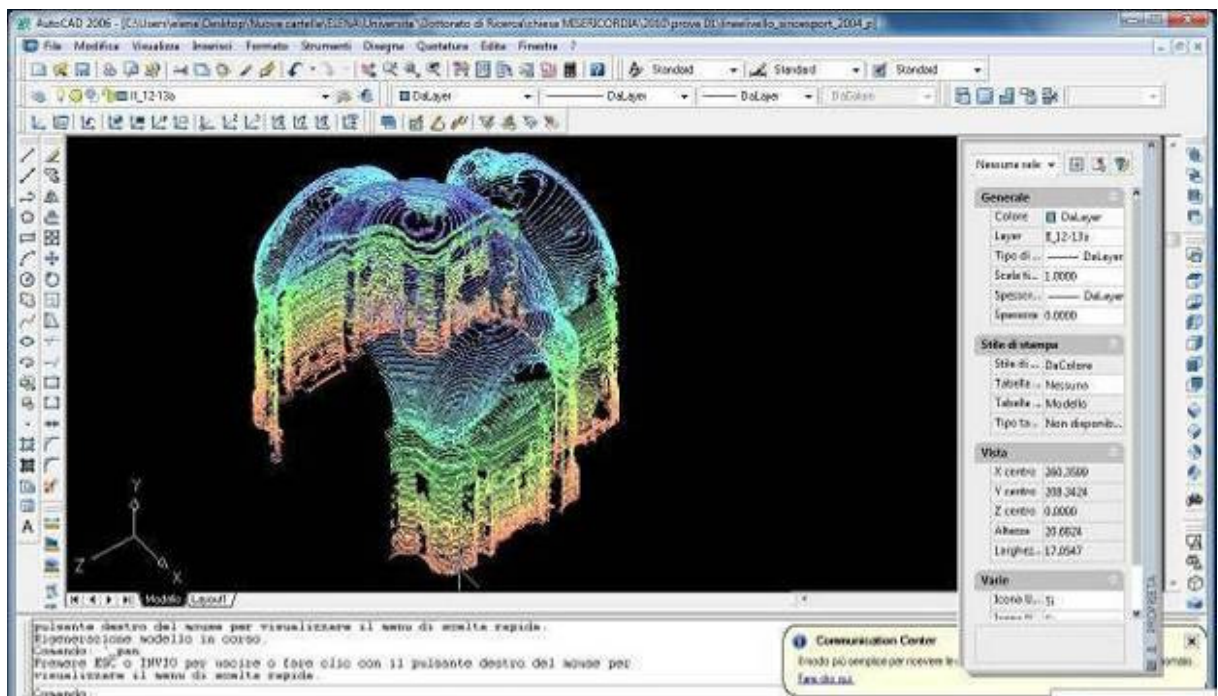
Figure 11 - Vectorization of the degradation mapping Figure 13 - contour lines with a pitch of 10 cm, useful to create a "virtual surface" by the laser scanner